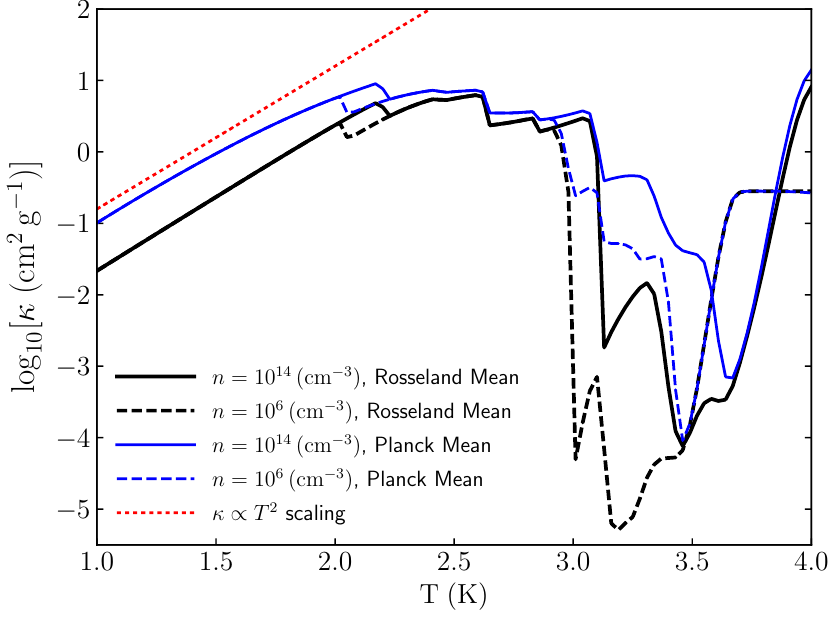
Figure 6. The Rossenland mean ( black lines ) and Planck mean ( blue lines ) opacities of dust from the temperature range 10K (cid:54) T (cid:54) 10 4 K. The gas density n = 10 14 cm − 3 and n = 10 6 cm − 3 . Figure reproduced using the publicly available code of Semenov et al. [305]. Other opacities [307–313] were also plotted and compared to Semenov et al.’s opacity in [305]. Please note that the Rossenland mean opacities are scaled as κ ∝ T 2 while the Planck mean opacities are slightly different from κ ∝ T 2 at low temperature. The opacities decrease significantly at the sublimation temperature of dust at T 1000 K. The rise in the opacity at higher temperature is due first to H scattering, then to bound- ∼ and free-free interactions, then to scattering off of free